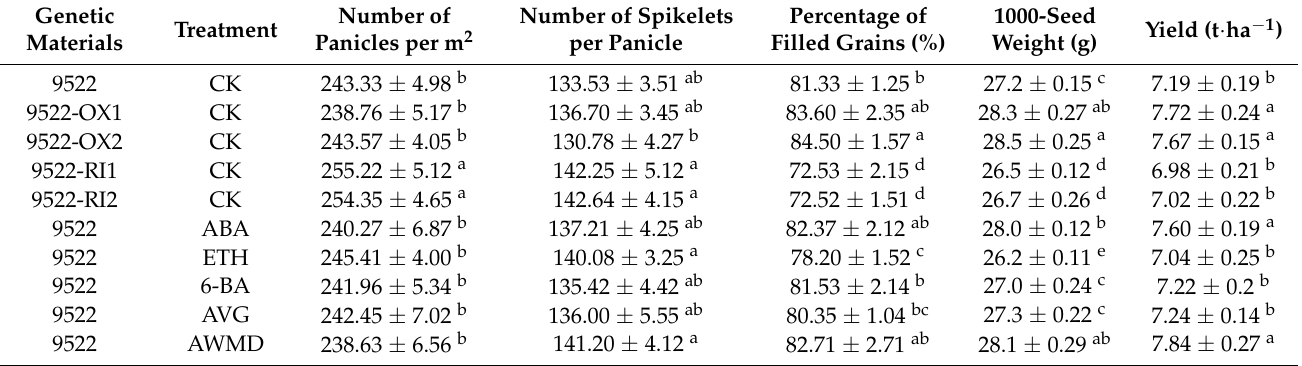
Table 1. The effects of gene Os NYC3 (a regulator of chlorophyll degradation), application of exoge- nous phytohormone, and alternate wetting and moderate drying (AWMD) irrigation on grain yield and yield